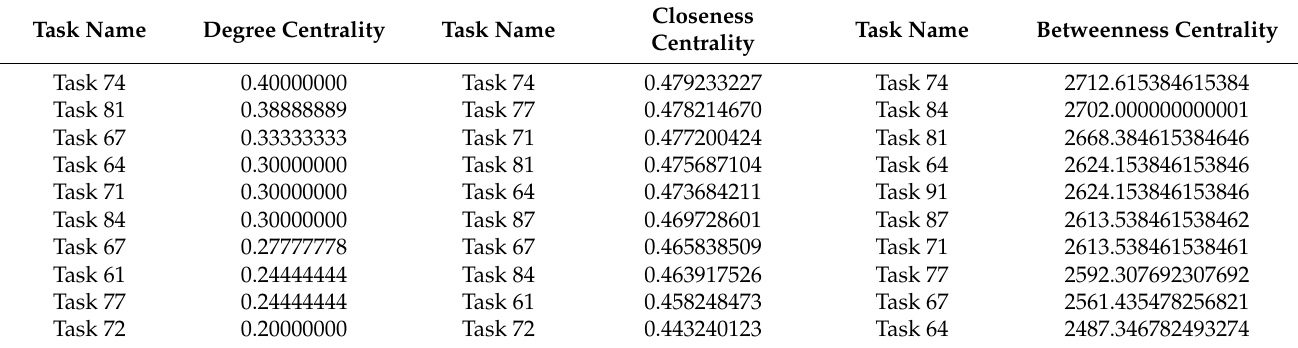
Table 8. Top 10 tasks based on different centrality